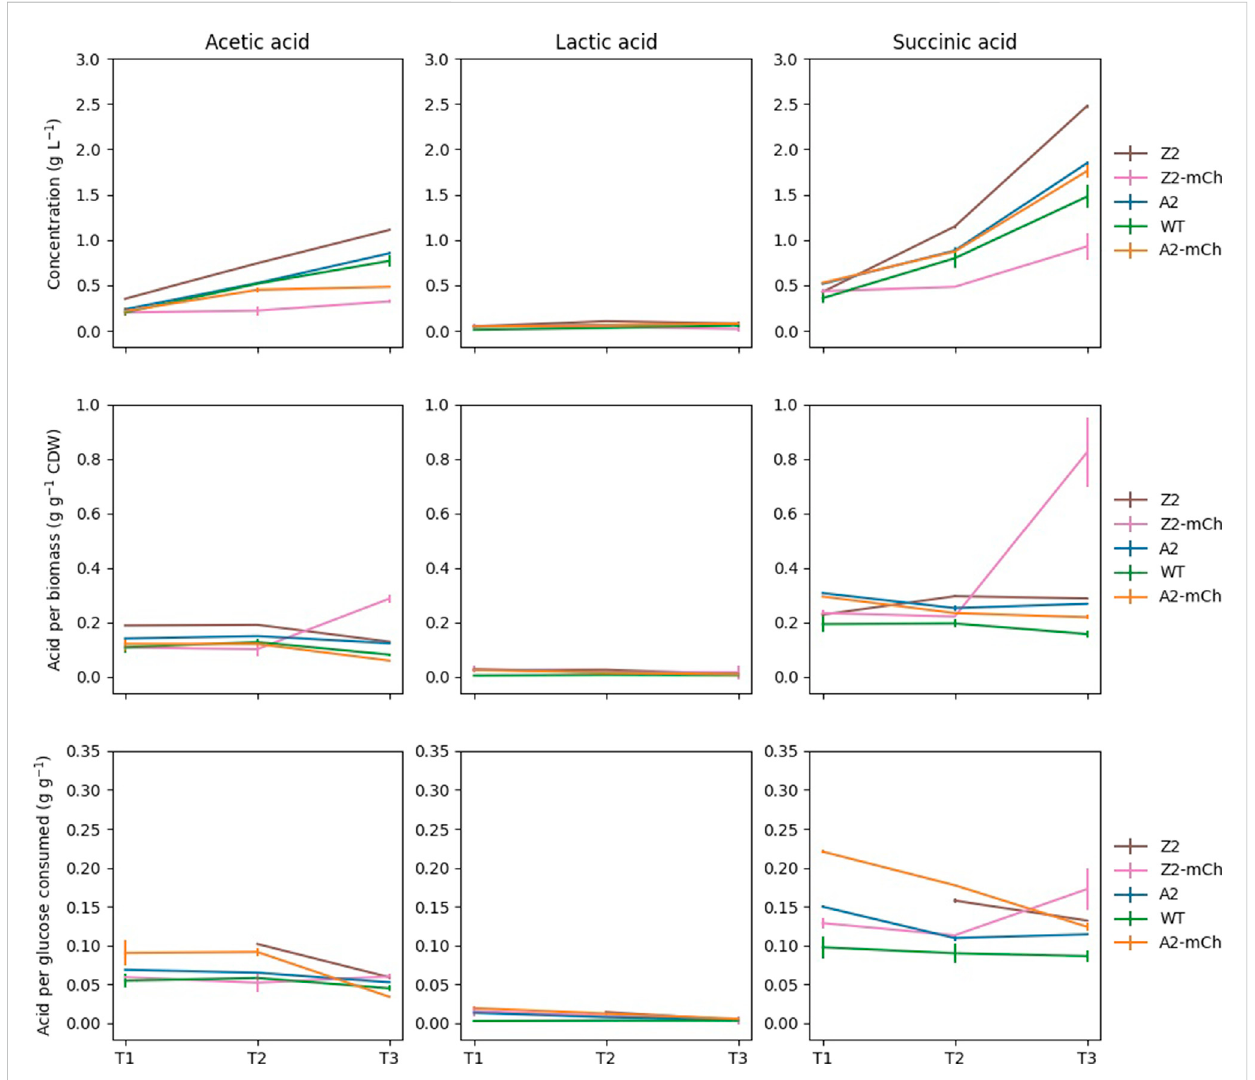
FIGURE 3 Evolutionoftheextracellularconcentrationsofselectedorganicacidsduringthetimeseries.Eachpointwasharvestedsimultaneouslywithsamples fortargetedmetabolitepro fi ling(T1,T2andT3).Errorbarsindicatestandarddeviations(SD).Extracellularorganicacidconcentrationsareexpressedinthe fi gure in g L -1 in the medium (top panels), acid produced relative to biomass at each given point (g g -1 CDW; middle panels); and per amount of glucose consumed at each time point (g g -1 glucose; bottom